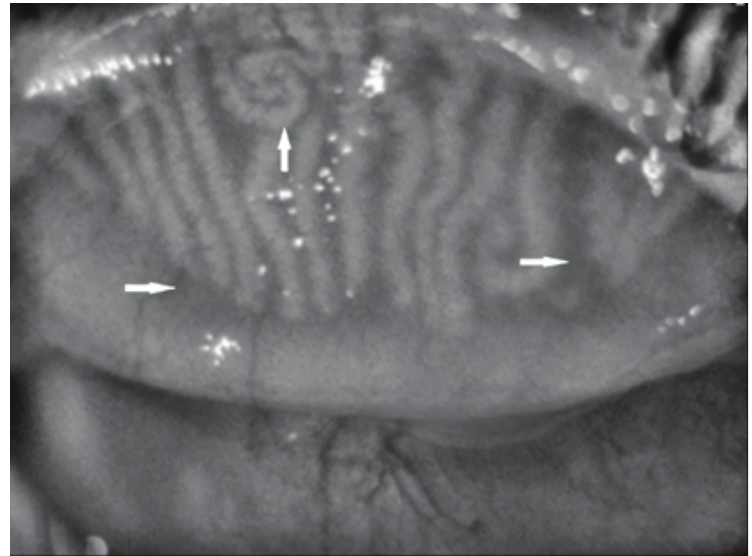
Figure 1. Horizontal arrows show atrophic areas and vertical arrow shows increasing